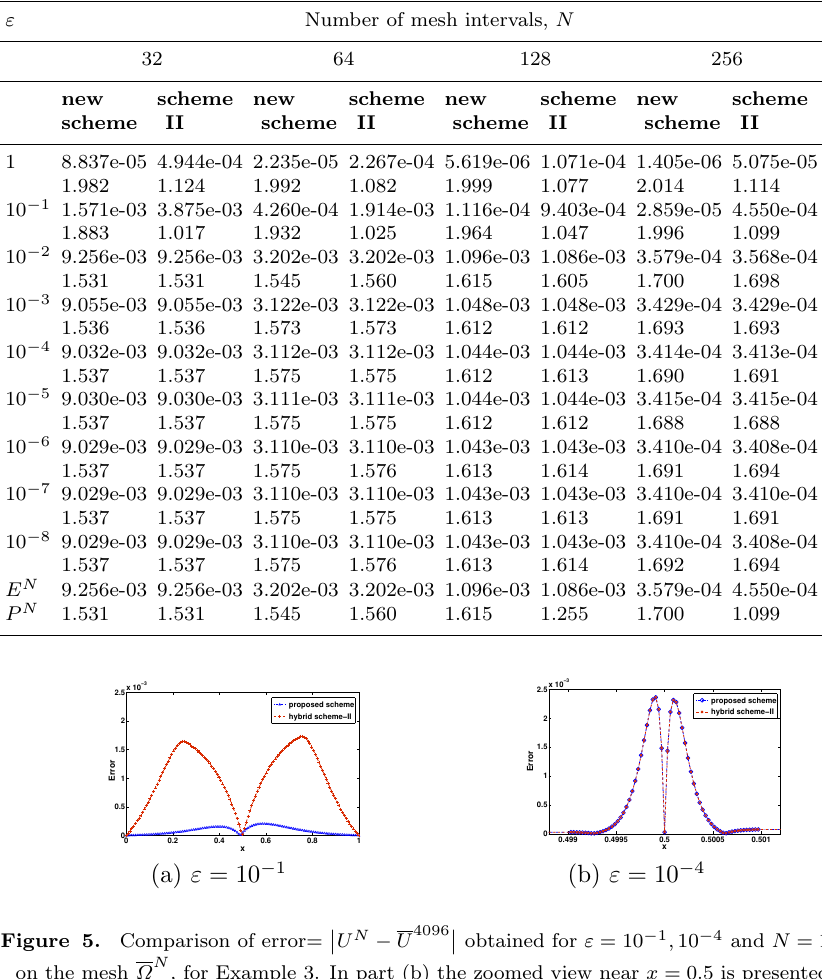
Table 2. Maximum point-wise errors and order of convergence for Example 2.